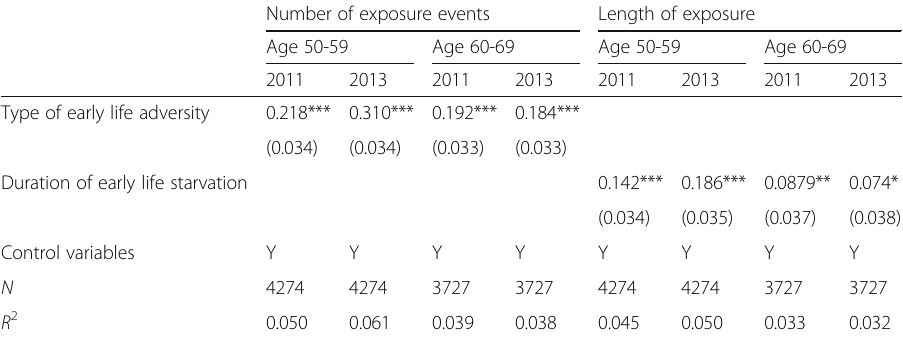
Note: Table 3 is a cross-sectional analysis using data from 2013; Table 4 is a panel data analysis matching the data from 2011 and 2013, with the sample sizes consistent between the 2years The model introduces the same control variables, including original family characteristics, initial health endowment, demographic characteristics, and provincial dummy variables * p < 0.1 ** p <